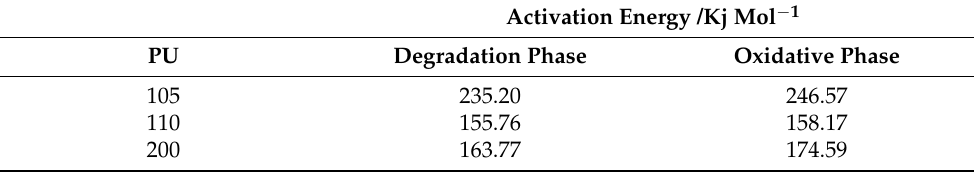
Table 3. Kinetic calculation results by the Kissinger